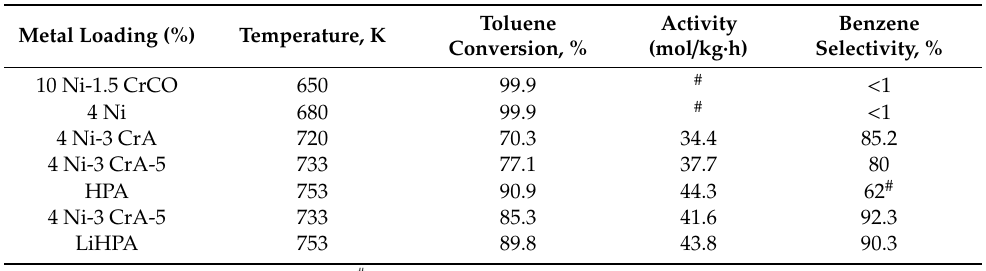
Table 3. Toluene hydrodemethylation over alumina supported Ni-containing catalysts WHSV = 1.5 h − 1 . Pressure 0.7 MPa (H 2 / Toluene =